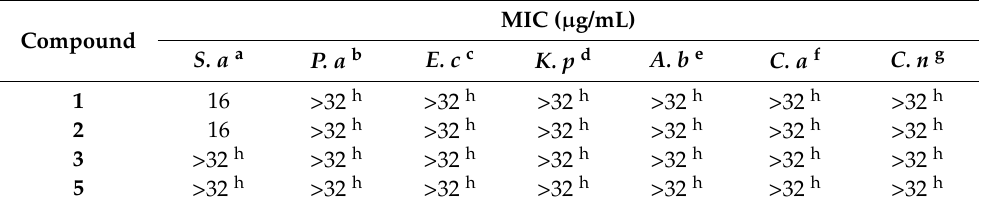
Table 2. Antimicrobial and antifungal activities of 1 – 3 and 5 . Compound